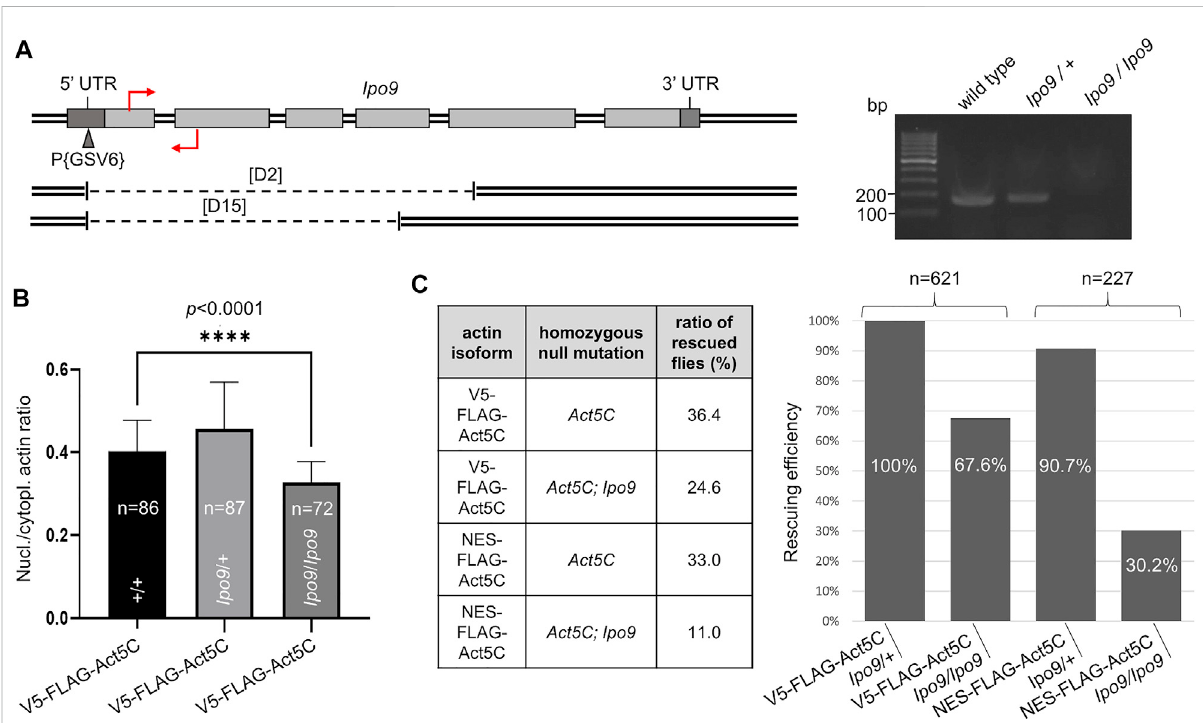
FIGURE 4 Lack of Ipo9 reduces nuclear actin level but has negative effect on viability only in combination with the NES tag. (A) The exon-intron structure ofthe DrosophilaIpo9 gene.Proteincoding(lightgreyrectangles)andnoncoding(darkgreyrectangles)exonsareshown.TheinsertionsitefortheP {GSV6}elementinthe5 ′ UTRismarkedwithatriangle.Deletedsegmentsin Ipo9 D2 and Ipo9 D15 areshownunderthemapbydashedlines.Primersfor RT-PCR are indicated by red arrows. Forward primer binding in the fi rst exon is located above; reverse primer binding in the second exon is located below the DNA. Gel shows RT-PCR products of 200 bp using the primers shown. (B) Bar chart presentation of the quanti fi cation of nuclear actin (V5-FLAG-Act5C, green) expressed from a transgene in wild type animals, and in heterozygote ( Ipo9/+) and homozygote ( Ipo9/Ipo9) Ipo9 null mutant background. “ n ” is the number of cells examined. Unpaired t- test was used for statistical analysis, p -value: * < 0 0001. Error bars represent standard deviation. (C) Summary of the rescue experiments with actin (V5-FLAG-Act5C) and NES-actin (NES-FLAG-Act5C) in Ipo9 null background. Thepercentageofrescuingef fi ciencywascalculatedasfollows.Thepercentageratioofthe fl iesrescuedwithV5-FLAG-Act5Cinheterozygous Ipo9 background( Ipo9 /+)wasconsideredas100%rescue,andthepercentageratiooftherescuedcategoryobtainedintheothercrosseswascompared to it. “ n ” is the total number of male offspring hatched in the given rescue